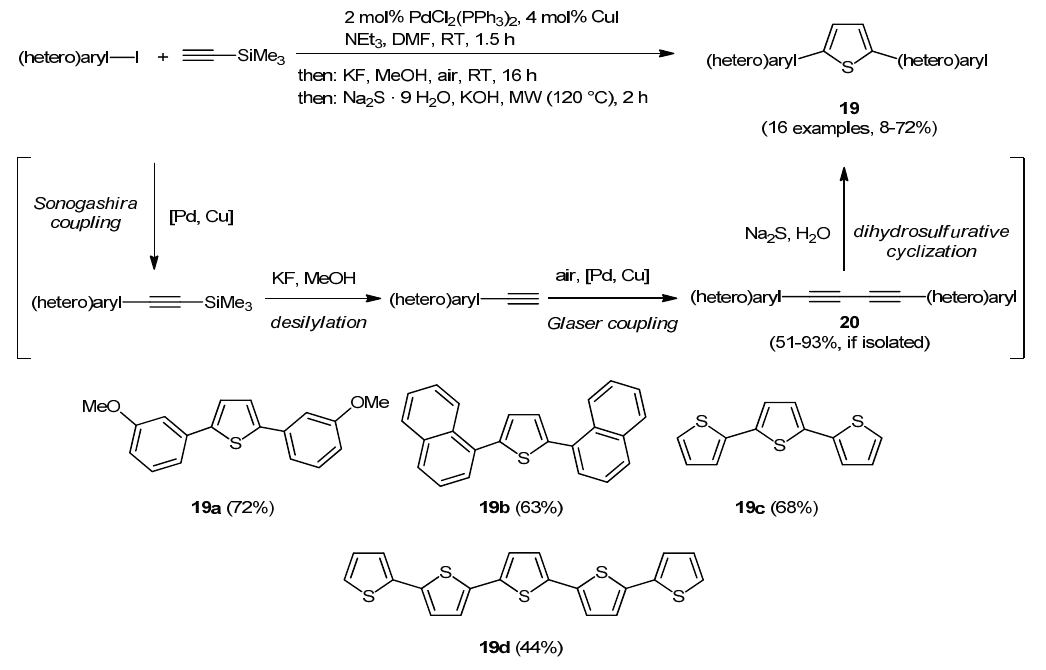
Scheme 12. Pseudo five-component Sonogashira-Glaser cyclization synthesis of